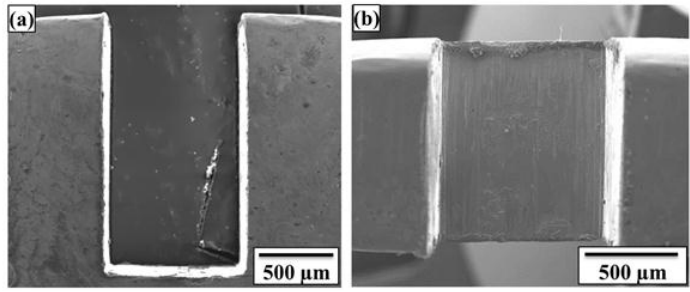
Figure 4. ( a ) Top and ( b ) side views of a shunt resistor trimmed with a square cut.